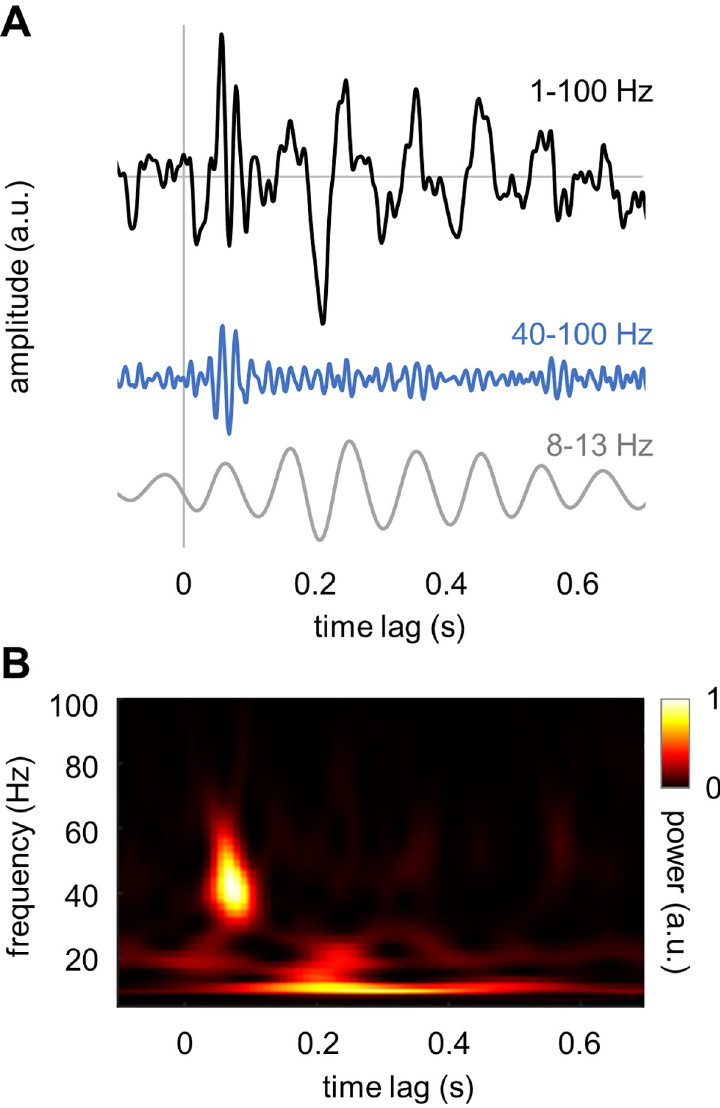
Fig 1. TRF of the human visual cortex derived from a random broadband visual input train. (A) The TFR filtered in the broad band (1–100 Hz; black line), the gamma band (40–100 Hz; blue line) and the alpha band (8–13 Hz; gray line). (B) Time-frequency representation of power of the TRF. Note that the TRF was computed for an occipital gradiometer that captures both the alpha band and gamma band